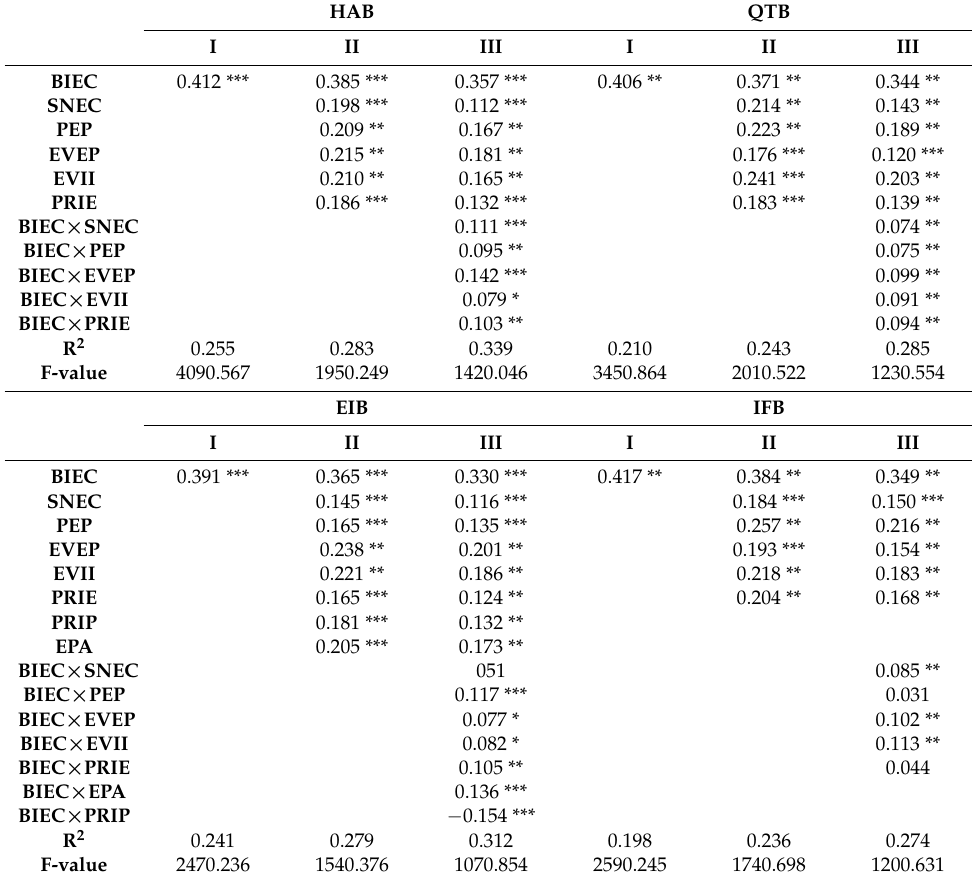
Table 5. Hierarchical regression analysis of the modulatory